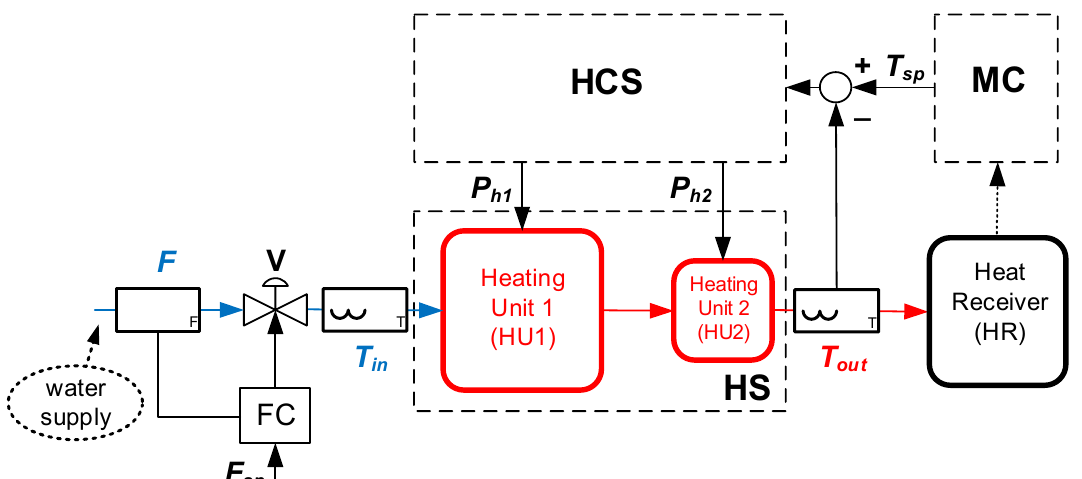
Figure 2. Schematic diagram of the proposed modification of HS. The new HS consists of two serially connected heating units (HU1 and HU2), and it becomes a double-input single-output dynamical system. Then, the dedicated HCS must be applied to cope with this control problem.